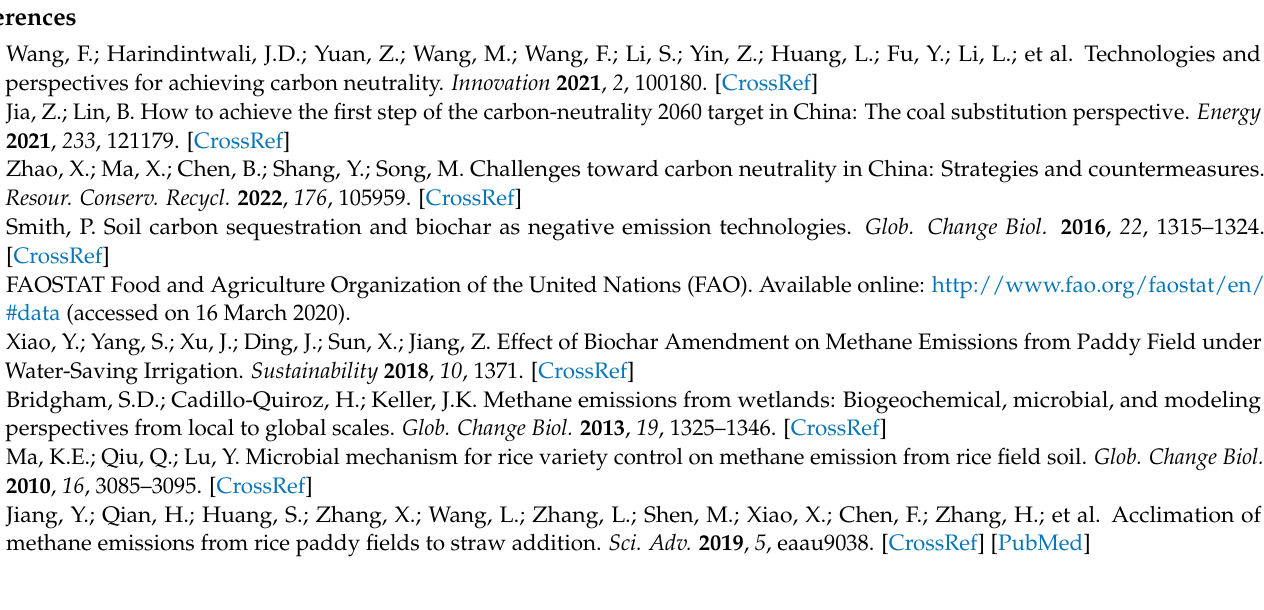
Table S2: Prediction of soil total carbon content in paddy field with different biochar incorporation; Table S3: Effect size of CO 2 emission with biochar amendment strategy under temperate continental monsoon climate; Table S4: Key environmental factors affecting carbon emission; Table S5: Default value of carbon emission factors; Figure S1: Effect size of CH 4 emission with nitrogen fertilizer under biochar amendment strategy; Figure S2: Effect size of CH 4 stimulation with nitrogen fertilizer under biochar amendment strategy; Figure S3: CH 4 emission promotion factor exploration; Figure S4: Effect size of N 2 O emission with phosphate fertilizer under biochar amendment strategy; Figure S5: Effect size of N 2 O emission with potassium fertilizer under biochar amendment strategy; Figure S6: The minimal carbon potential with biochar incorporation into paddy soils; Figure S7: The maximal carbon potential with biochar incorporation into paddy soils; Figure S8: The minimal carbon reduction induced by rice yield promotion and carbon emission from GHGs with biochar incorporation in paddy field; Figure S9: The maximal carbon reduction induced by rice yield promotion and GHGs mitigation with biochar incorporation in paddy field; Figure S10: The relationship of soil background pH and N 2 O difference with biochar amendment. Positive values represent for N 2 O stimulation and negative values represent for N 2 O reduction after biochar was